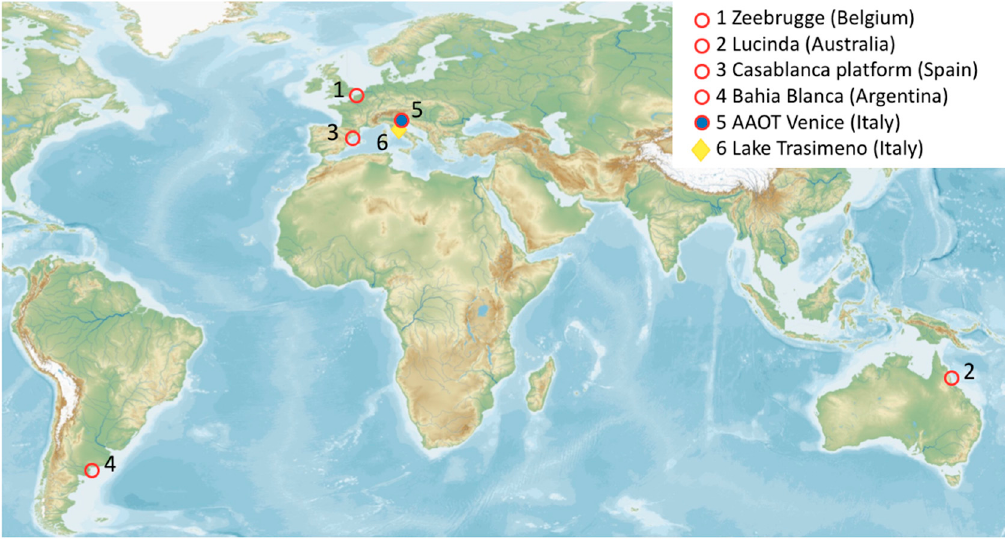
Figure 1. Distribution of in situ dataset: red dots are for AERONET-OC sites, blue dot is for PANTHYR site (colocated with the AERONET-OC AAOT Venice), and yellow diamond is for the WISPStation site.